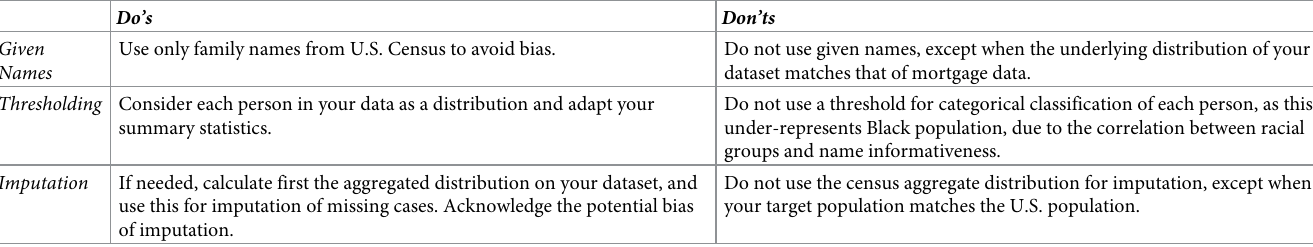
Table 4. General recommendations for implementing a name-based inference of race for U.S.